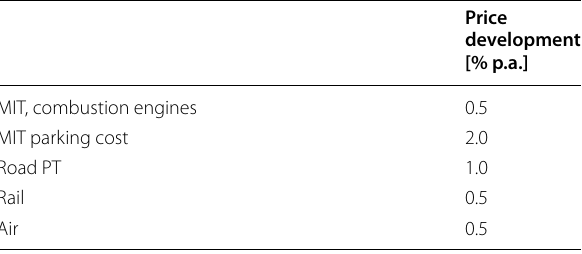
Table 6 Yearly user cost increase between 2017 and 2035, following assumptions from [2,